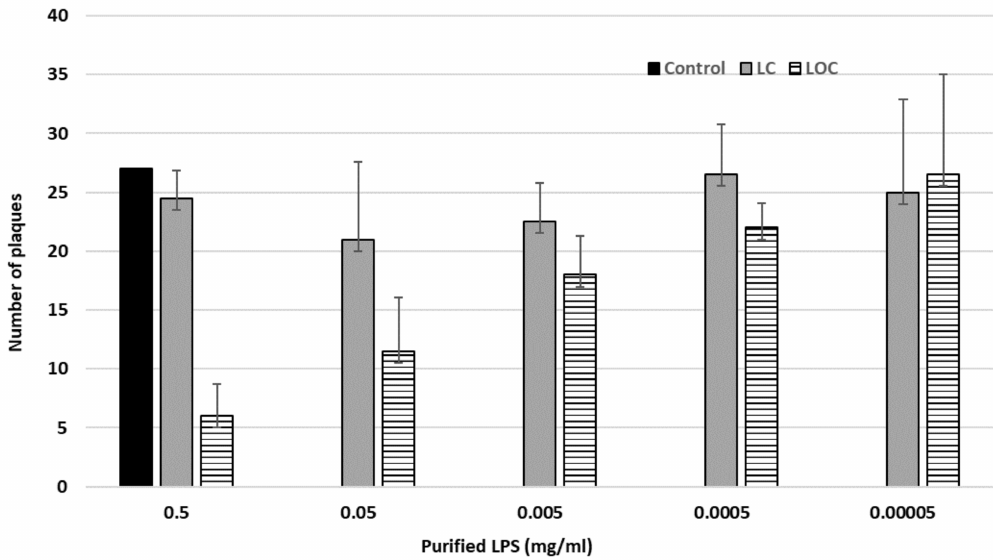
Figure 7. Inhibition assay of the phage fPS-7 with the purified LPS derived from wild type Ye O:3 strain 6471/76 and from the rough derivative YeO3-R1. The values shown represent the average of two independent experiments. The black bars (the control) represent the number of plaques shown when plating fPS-7 on the host bacteria without addition of lipopolysaccharide (LPS). The grey bars (LC) represent the number of plaques appeared when plating the mixture of fPS-7 with the purified LC on the permissive host, which showed an average number of plaques of 21 to 26.5 (relative to the host which was around 28). A clear drop in the number of plaques is shown on the LOC bars; the least number of plaques is seen with the undiluted LOC preparation and the dose response is demonstrated upon the dilution of the LOC. Error bars represent the standard deviations of the means of number of plaques obtained from the phage